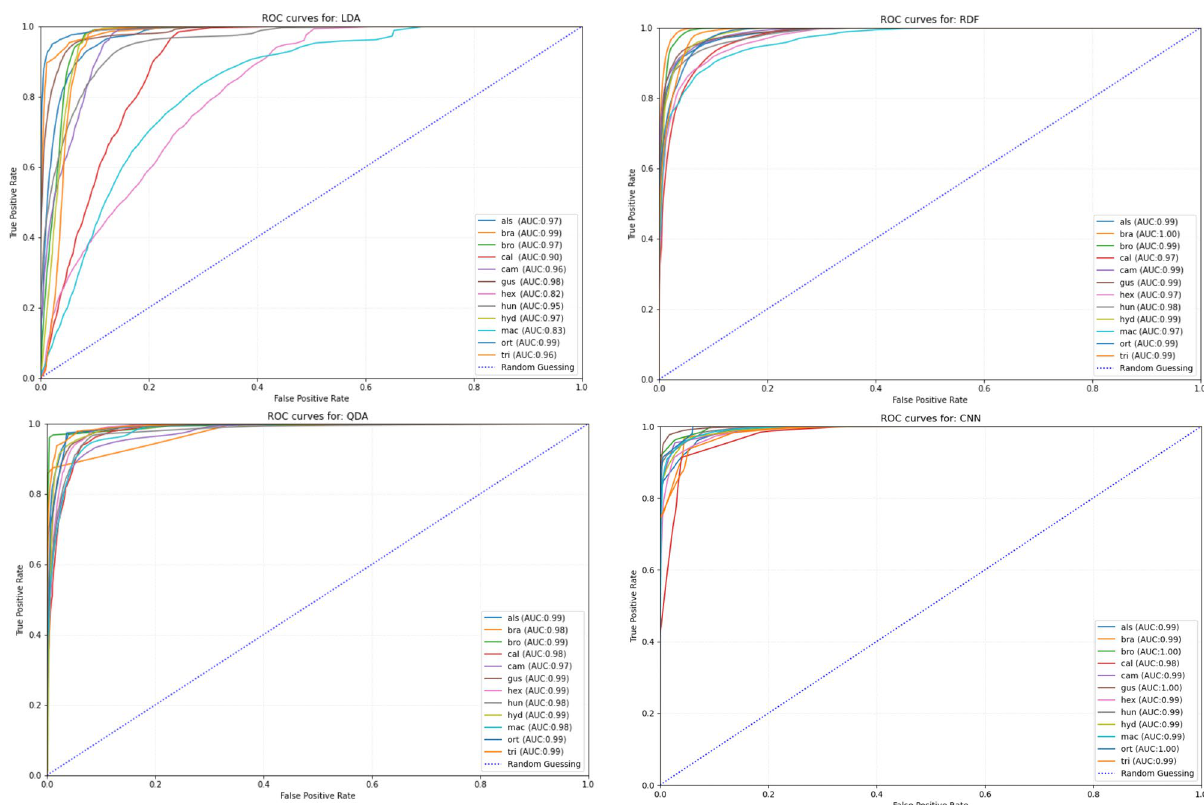
Figure 3. ROC curve and AUC value, for 100 random samples of statistical analysis: Random Forest (RDF), Linear Discriminant Analysis (LDA), Quadratic Discriminat Analysis (QDA) and Deep Learning CNN. (als)— Elatine alsinastrum L.; (bra)— E. brachysperma A. Gray; (bro)— E. brochonii Clavaud; (cal)— E. californica A. Gray; (cam)— E. campylosperma Seub; (gus)— E. gussonei (Sommier) Brullo, Lanfr., Pavone & Ronsisv.; (hex)— E. hexandra (Lapierre) DC.; (hun)— E. hungarica Moesz; (hyd)— E. hydropiper L.; (mac)— E. macropoda Guss.; (ort)— E. orthosperma Düben; (tri)— E. triandra Schkuhr.